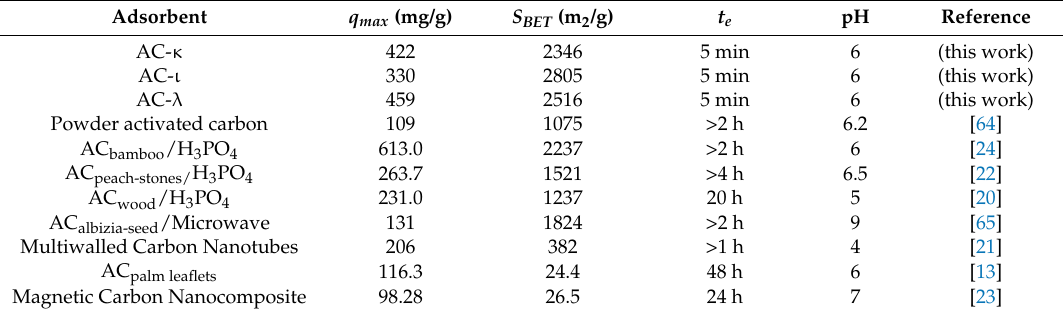
Table 5. Comparison of the maximum CIP adsorption capacity ( q max ), time to achieve the equilibrium ( t e ) and specific surface area ( S BET ) of various carbonaceous adsorbents (T = 25 ◦ C).